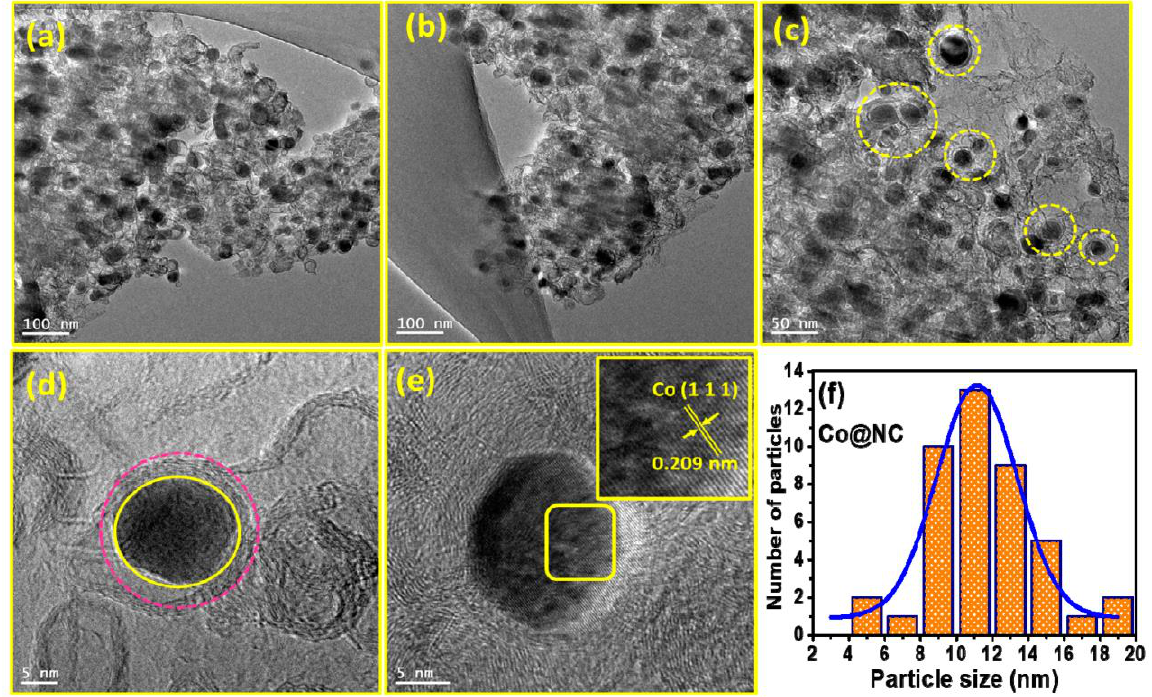
Figure 3. TEM images ( a – e ) of Co@NC nanostructures ( f ) histogram of particle size and statistical distribution curve of Co nanoparticles derived from TEM images.